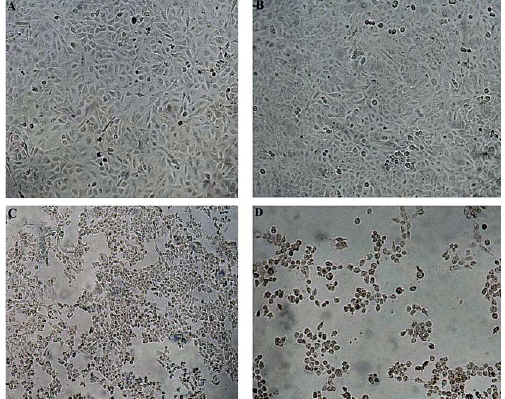
Fig. 5. Phomopsis sp., (A) HEp2 cell control, (B) HEp2 cells after 24 hours, (C) HEp2 cells after 48 hours, (D) HEp2 cells after 72 hours.